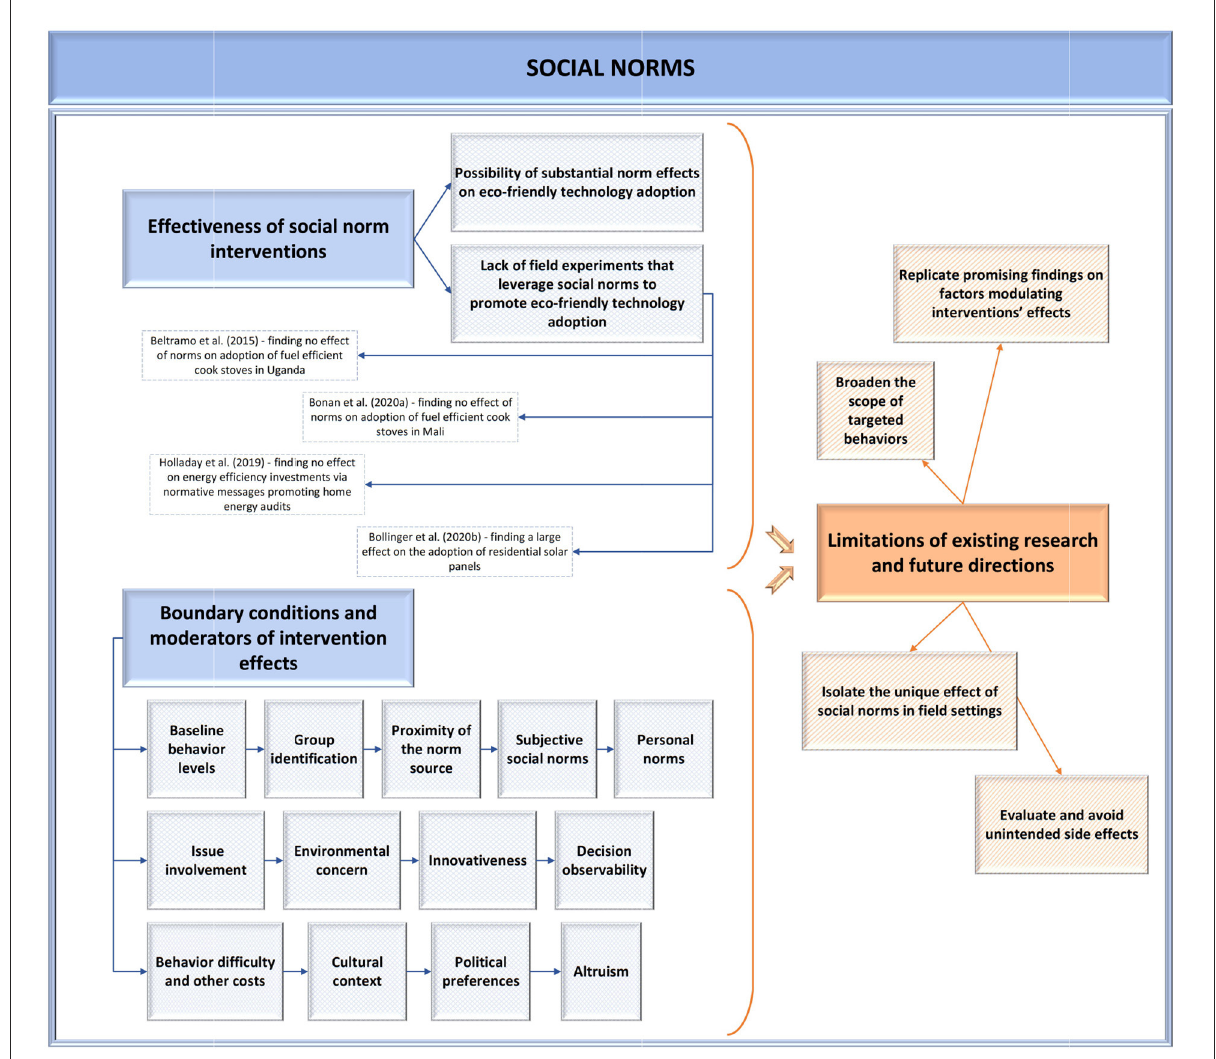
FIGUREA1 Overview of findings on social